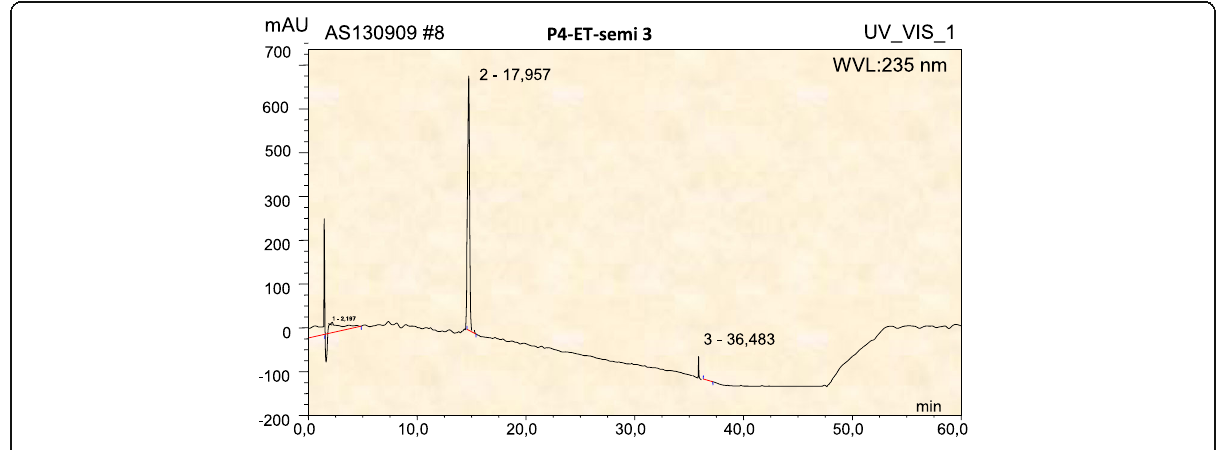
Fig. 7 HPLC chromatogram of salicylamide derivative